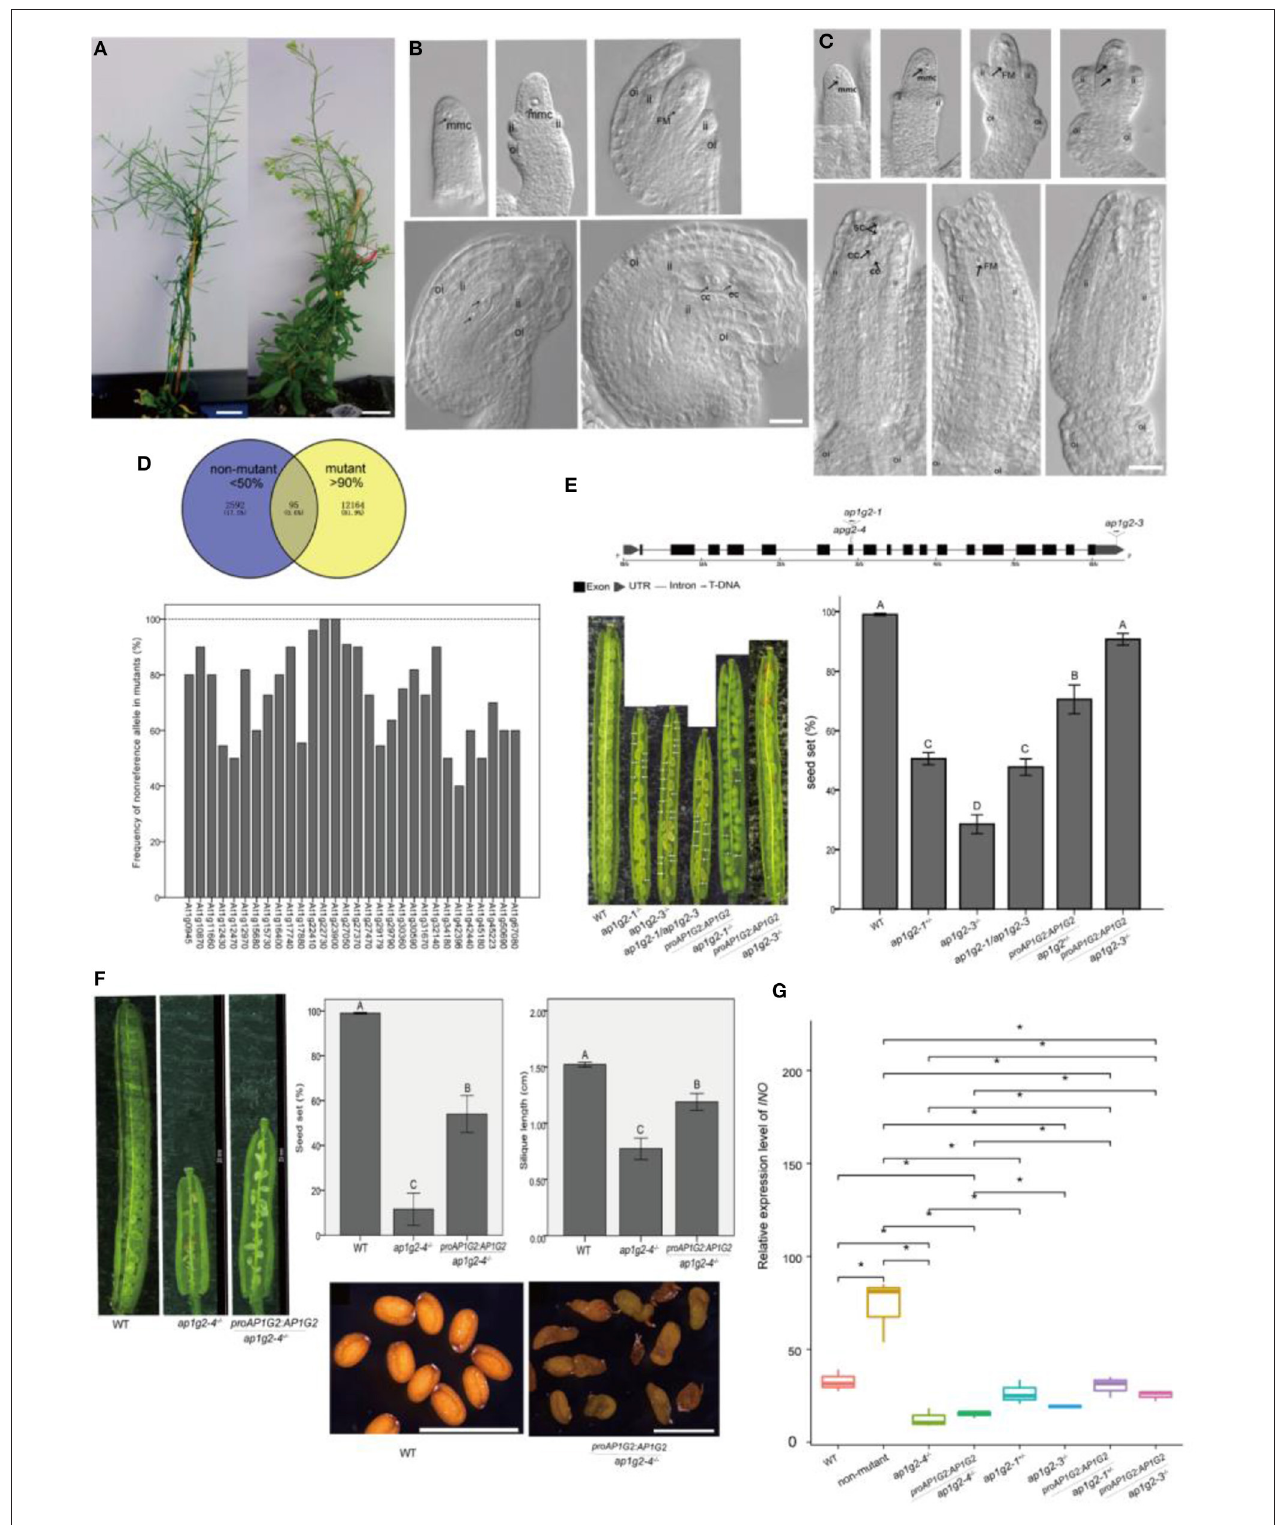
FIGURE 1 | (A–C) Phenotypes of the EMS-induced sterile mutant. (B,C) Ovule development in WT and the EMS-induced sterile mutant. A scale bar = 20mm in (A) . A scale bar = 20 µ m in (B,C) , ii, inner integuments; oi, outer integuments; mmc, megaspore mother cell; FM, functional megaspore; cc, central cell; ec, egg cell; sc, synergid cells. (D) Ninety-five candidate SNPs with the non-reference allele > 90% frequency in the mutant pool and < 50% in the non-mutant pool, and frequency of the non-reference allele, which changed amino acid in homozygous mutants of BC2 progeny. (E) Schematic (Hu et al., 2015) representation of the gene AP1G2 ,